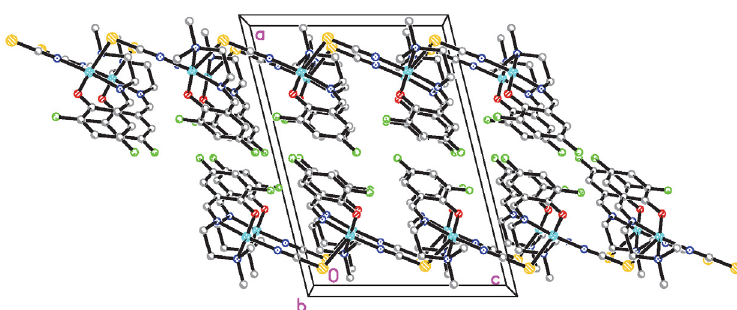
Figure 4. Molecular packing structure of complex 2 , viewed along the c